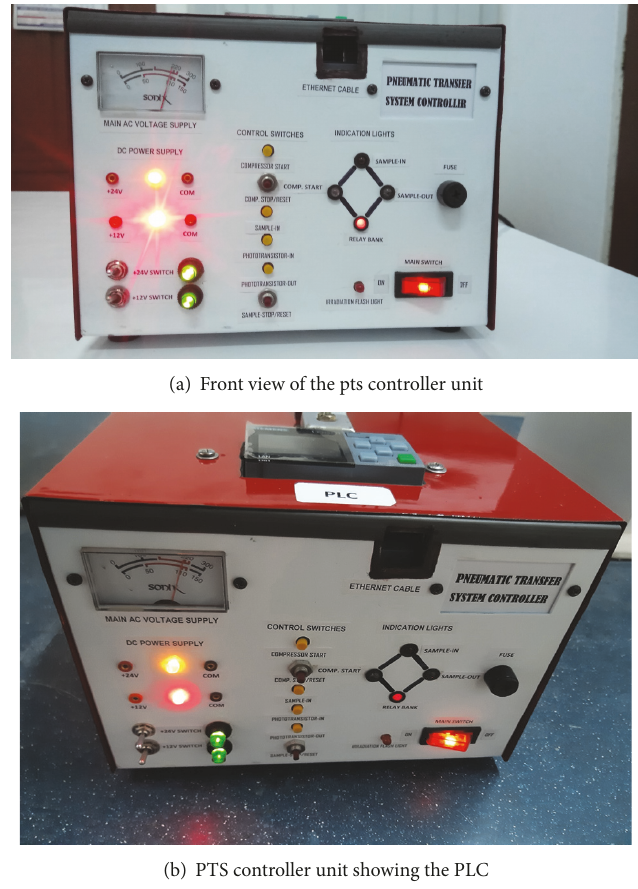
LED on the controller alerts the operator that the irradiated sample is transferred from the reactor onto the detector. Bulbs for S 1 and S 3 of Figure 21 are “ON” to show the repetition of the irradiation cycle. The compressor bulb will go “OFF” only when the irradiation is over as per the program of the